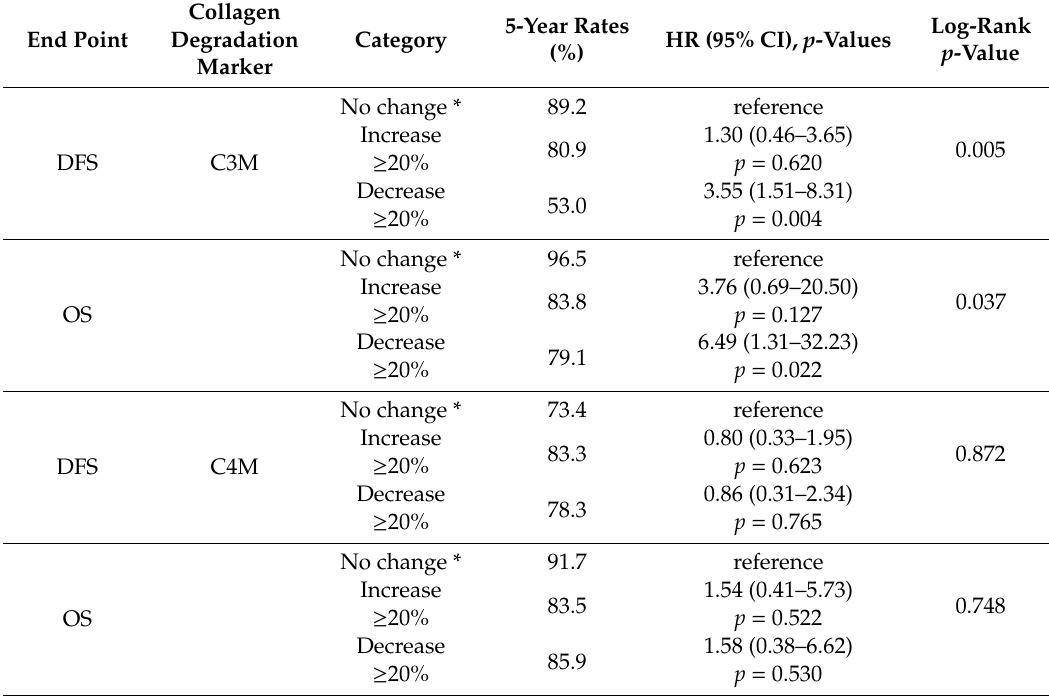
Table A2. Analysis of survival and changes in serum levels of C3M / C4M.